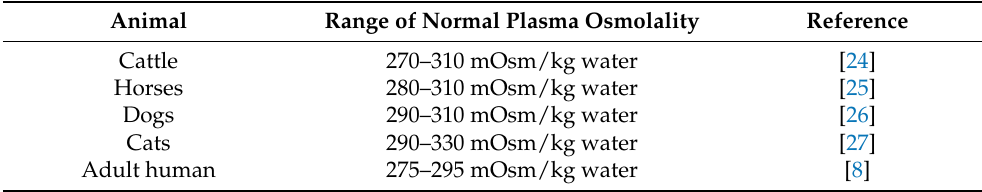
Table 4. The normal plasma osmolality parameters for selected